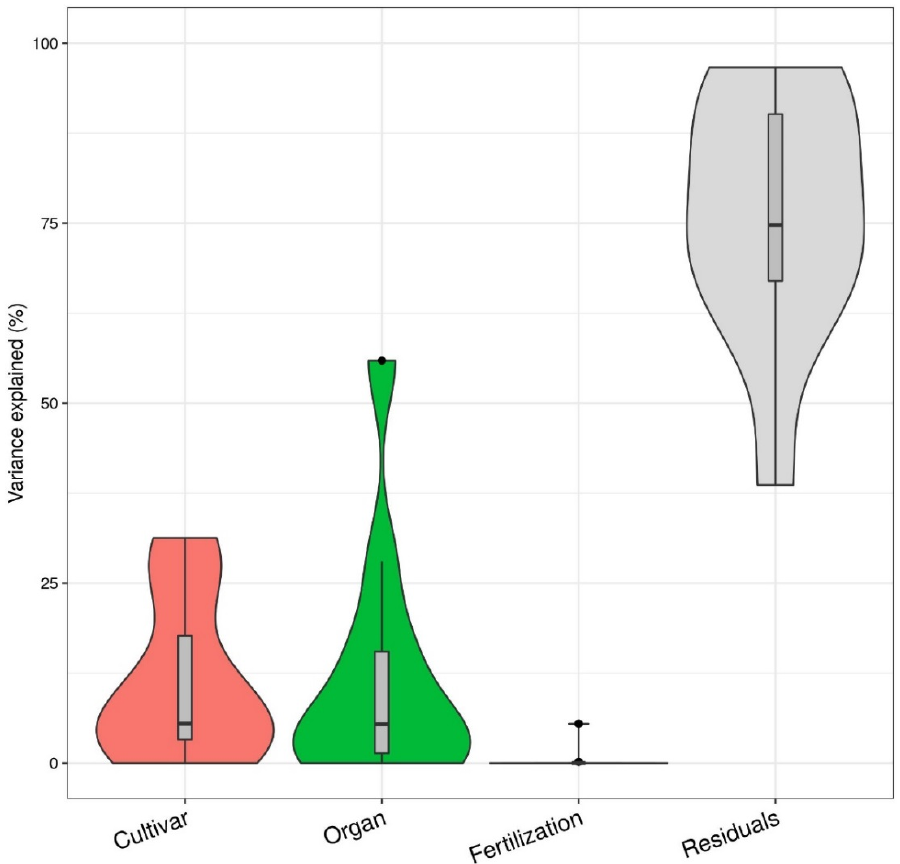
Figure 1. Violin plots representing the distribution of the percentage of explained variance associated with the cultivar (red), the organ (green), and the fertilization (blue) in the linear random models, as well as the model residuals (grey). The rectangular box within each violin represents the interquartile range with its upper and lower whiskers, whereas outliers are represented by black dots.